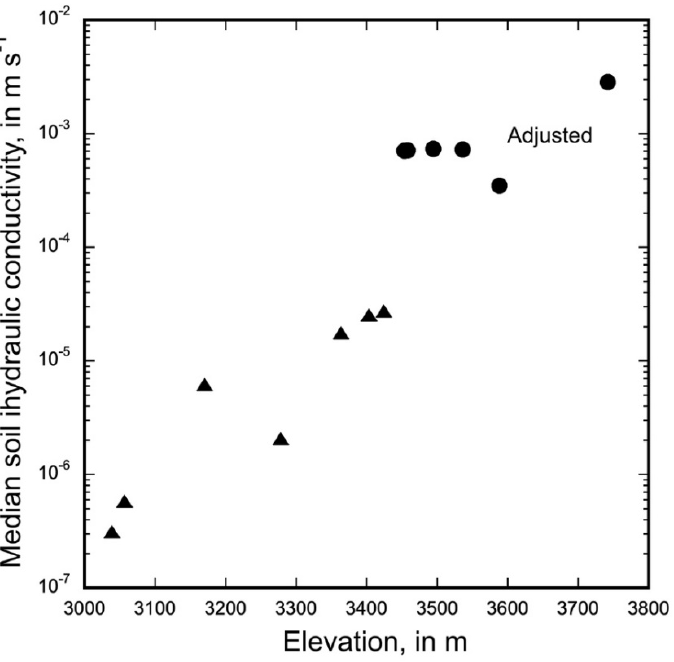
Figure 5. Elevation plot of median hydraulic conductivity on Niwot Ridge. Subalpine values shown as triangles. Six measured alpine values (circles) were adjusted upward using the infiltration rate (1.23 × 10 − 2 m s − 1 ) of Davinroy [42], based on the percent of openwork gravel estimated using image classification (23.0% above 3600 m, 2.7% between 3600 m and 3500 m and 5.6% between 3500 m and tree line). Upper and lower quartile boundaries are displayed in Figure 4.